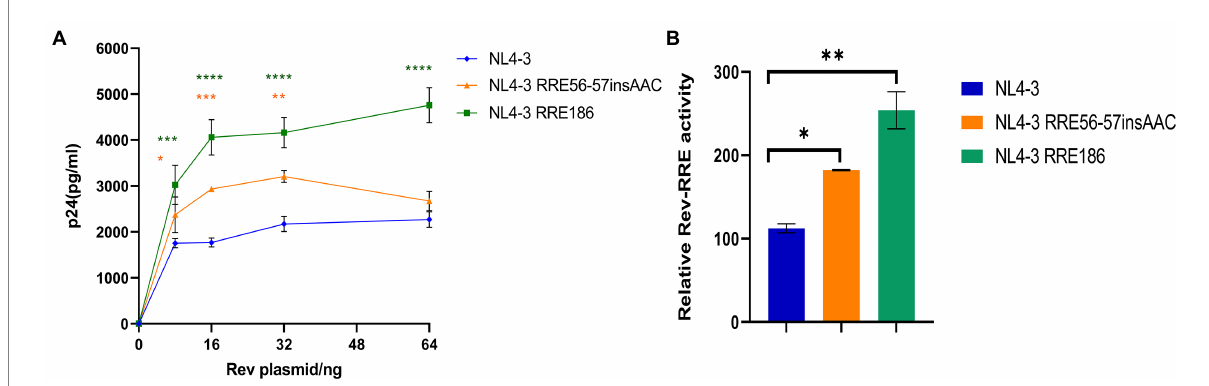
FIGURE 7 Relative function of NL4-3 and mutant RREs. (A) Gag/Pol reporter assay and variation of the concentration of p24 expressed by the reporter gene with the change of the concentration of the Rev expressing plasmid when NL4-3 and each mutant RRE were combined with NL4-3-Rev. (B) The relative activity of Rev-RRE when NL4-3 and each mutant RRE is combined with NL4-3-Rev. Each experiment was repeated twice, and bars show the standard error of the mean from two replicates. * p < 0.05, ** p < 0.01, *** p < 0.001, and **** p < 0.0001, compared to NL4-3.